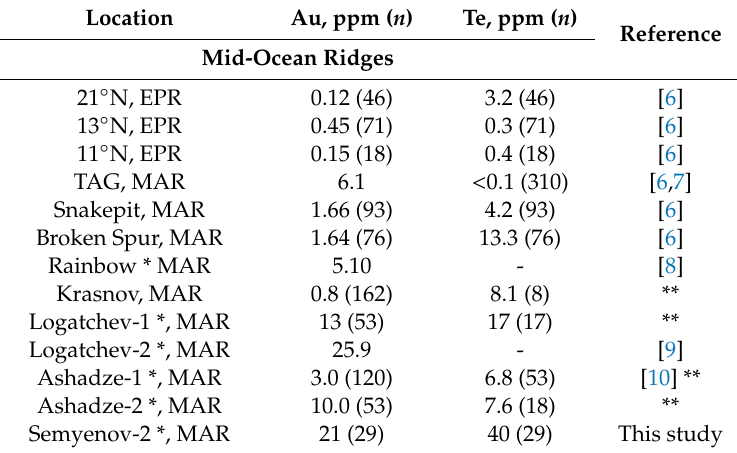
Table 1. Gold and tellurium content of SMS (East-Pacific Rise, Mid-Atlantic